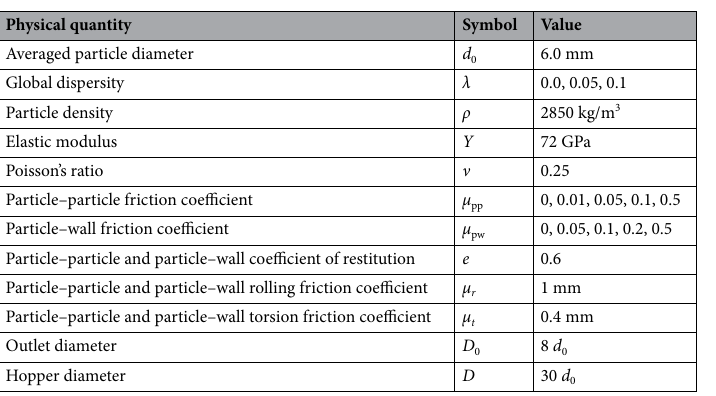
Table 4. Case parameters in